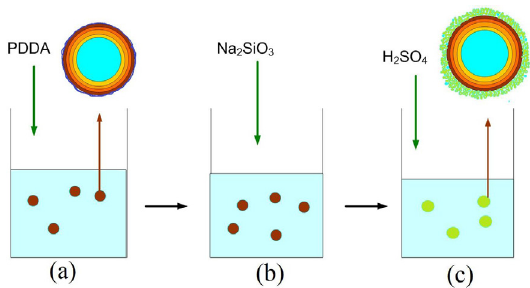
Figure 2. Preparation scheme of the assembling of silica layer on the surface of silica core/four-layered ferrite shell particles (sample CF4-S).